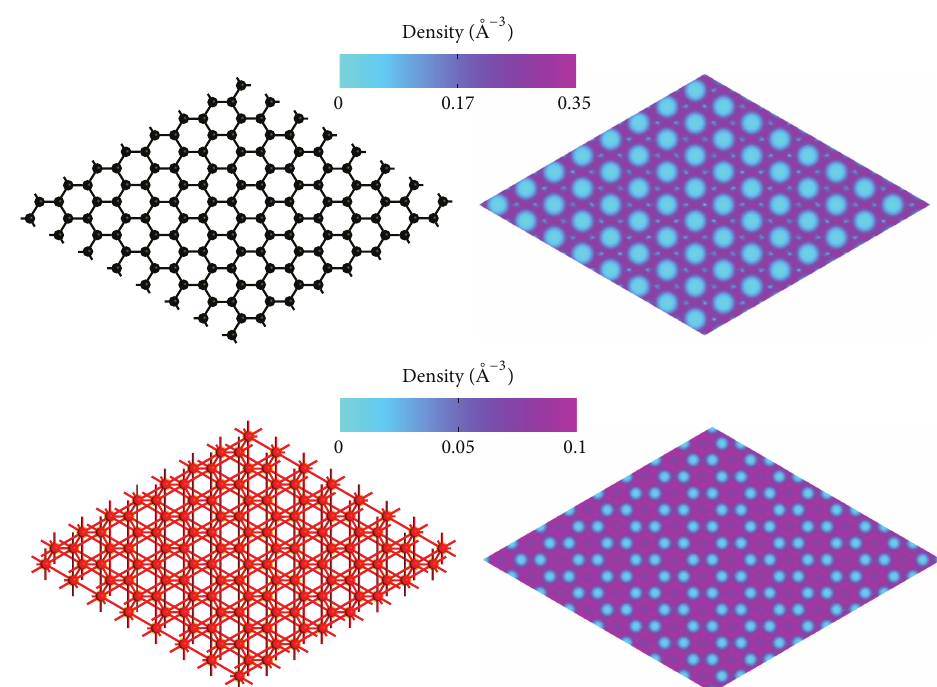
Figure 1: The structure (left) and calculated electron density (right) for a pure graphene sheet (top) and theoretical gallium sheet (bottom).